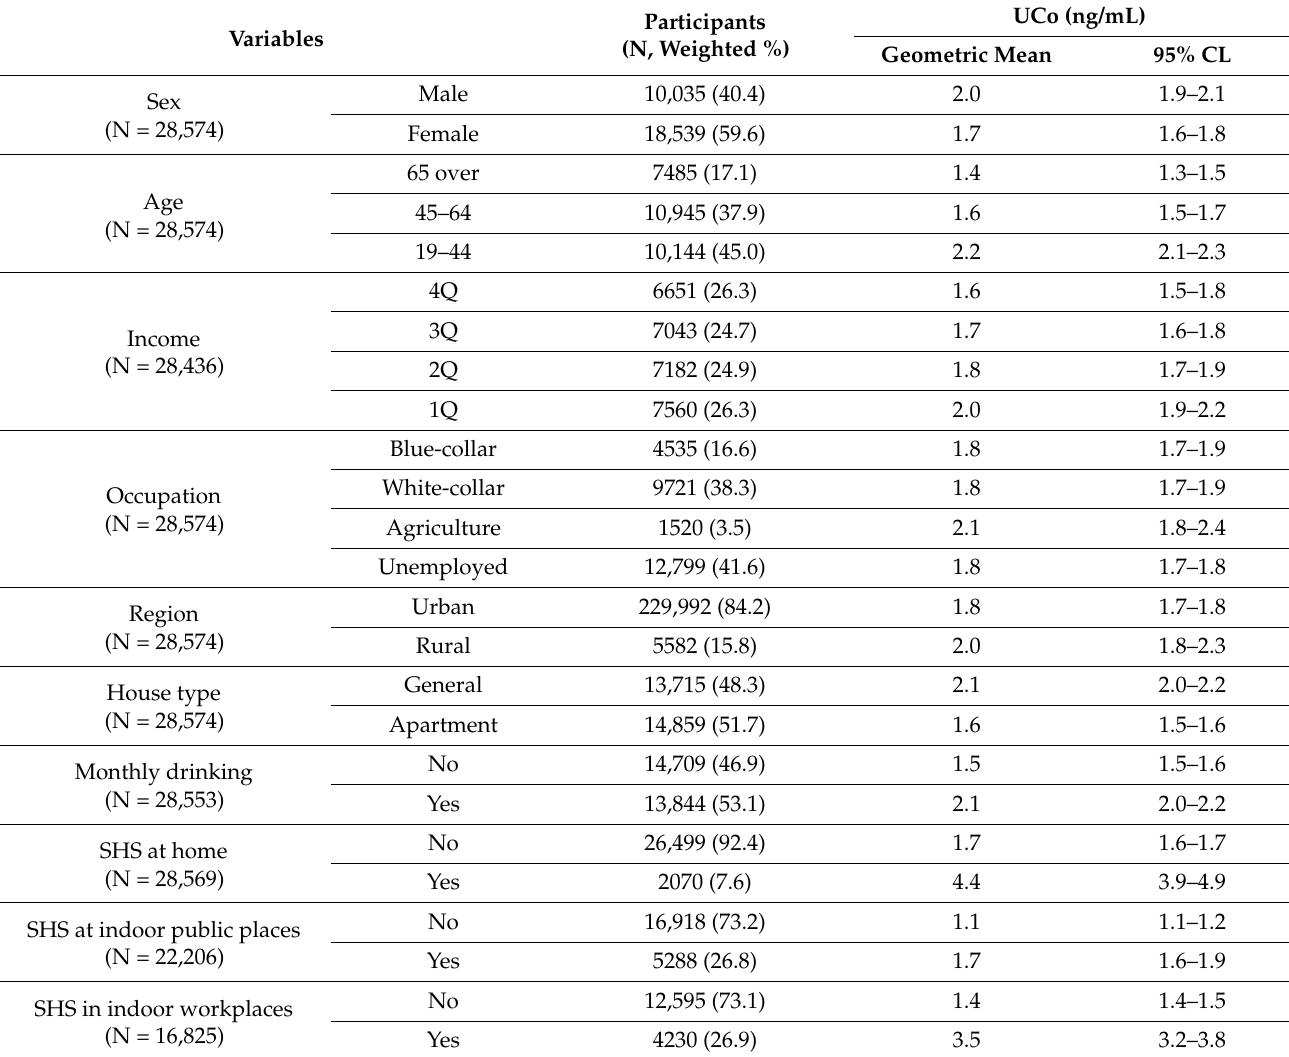
Table 2. Urine cotinine concentration in participants by characteristics.